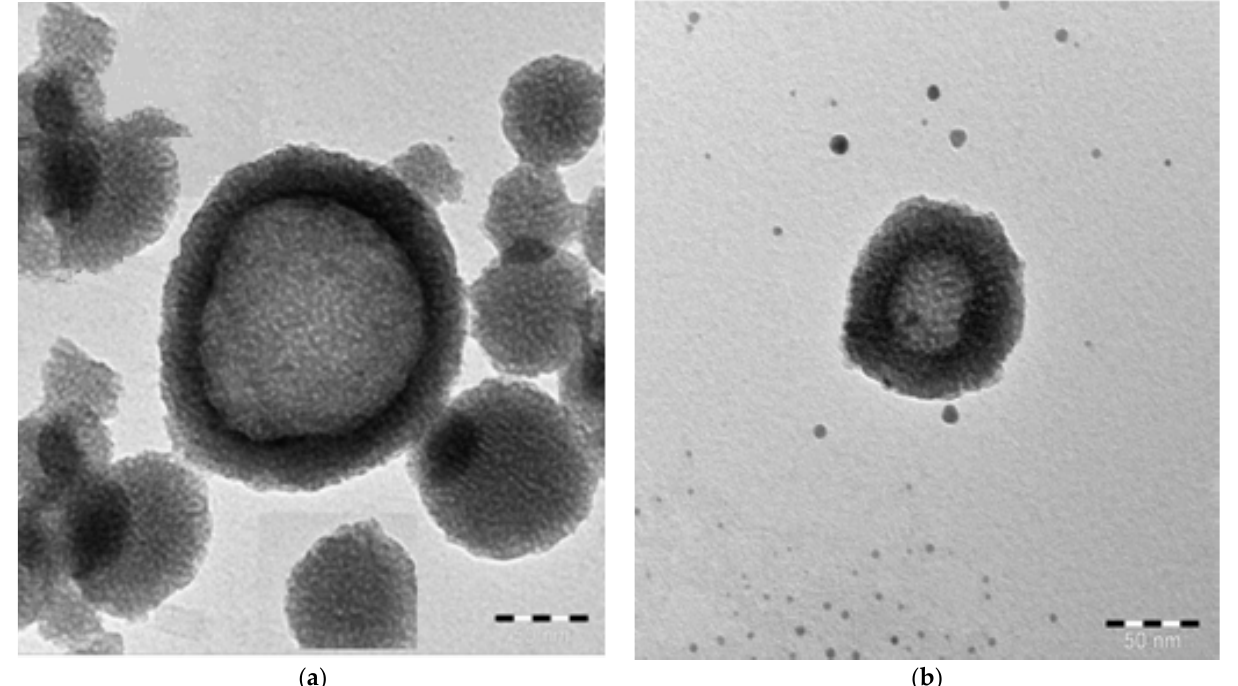
Figure 3. TEM images for the ( a ) GA/MNP and ( b ) MNP distribution.